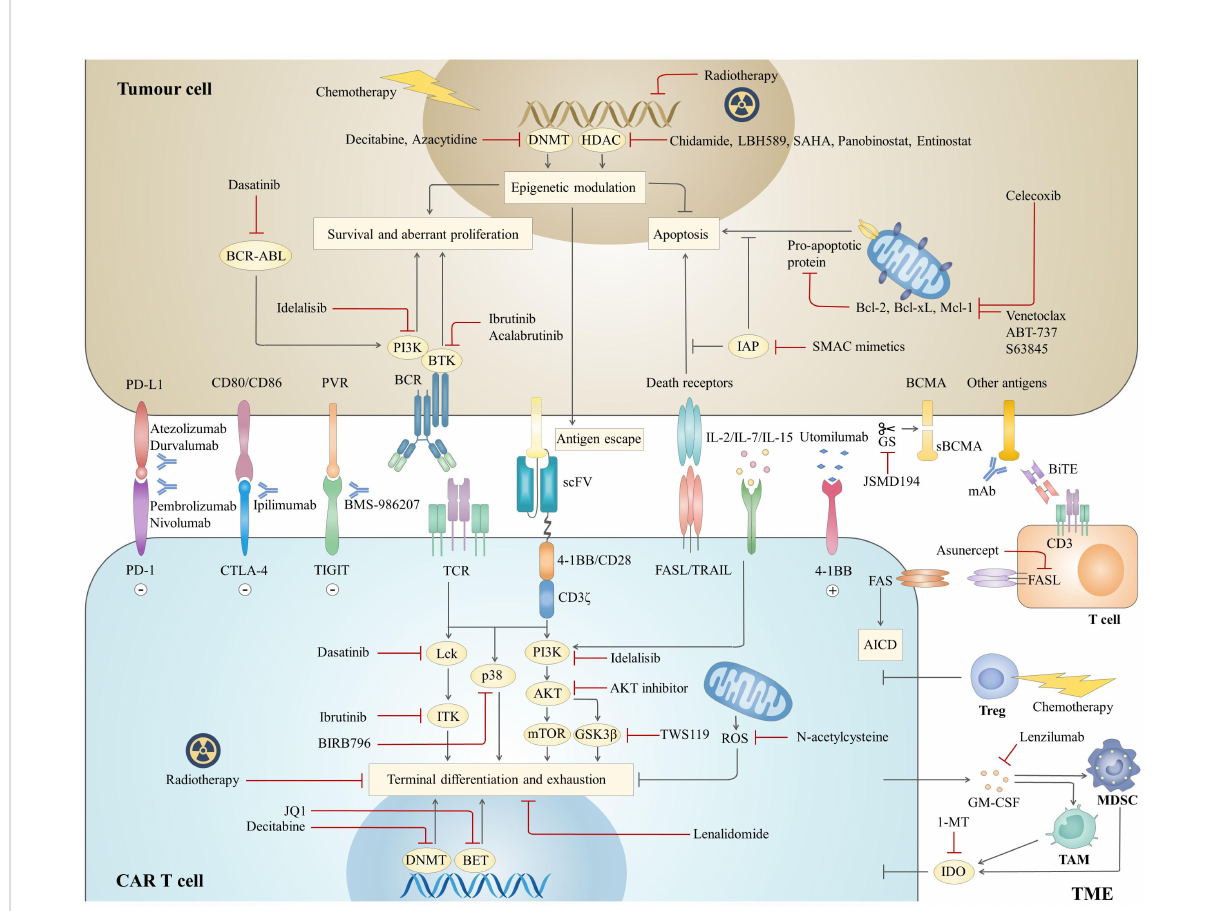
FIGURE 2 Mechanisms of combination strategies with CAR T cell therapy. The combined agents mainly focus on three aspects to optimize antitumor effects, including tumour cells, CAR T cells and the TME. For CAR T cells, attention is given to targeting different pathways to prevent terminal differentiation and exhaustion. In addition, inhibition of the Fas pathway prevents AICD, the other mechanism to prolong CAR T cell survival. For tumour cells, combined therapies are expected to both directly inhibit tumour survival and boost the cytotoxicity of CAR T cells by sensitizing tumours to apoptotic signalling or upregulating antigen expression. Components of the inhibitory microenvironment are also emerging as promising targets to enhance the effectiveness of CAR T cell therapy. BCR, B cell receptor; sBCMA, soluble B cell maturation antigen; mAb, monoclonal antibody; BiTE, bispeci fi c T cell engager; TCR, T cell receptor; ROS, reactive oxygen